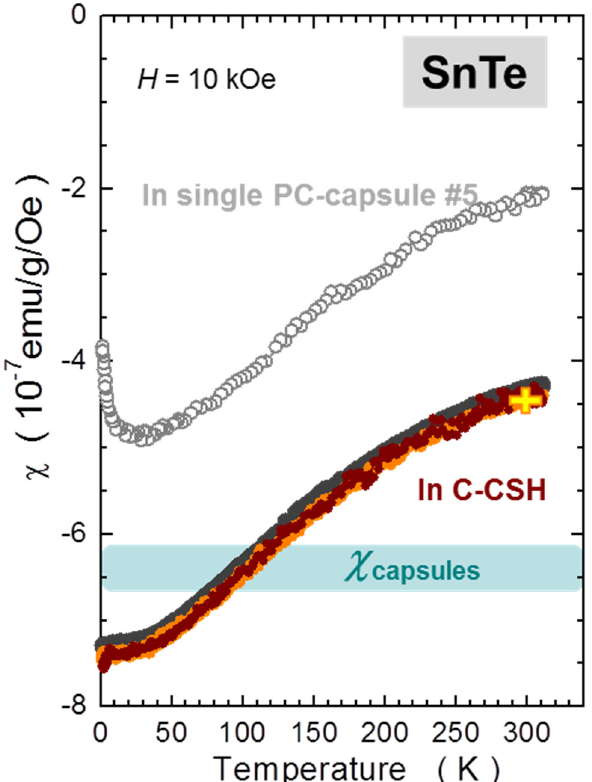
Figure 13. Temperature dependence of the magnetic susceptibility χ of SnTe established in this study by various methods. The background dark grey symbols mark the χ -benchmarking measurement of a large 58 mg crystal. Open gray symbols indicate the measurements of 2.1 mg crystallite in a single polycarbonate capsule #5. The orange symbols indicate the results obtained for the same minute crystallite mounted on a magnetically clean and uniform Si stick. The brown symbols indicate the results of the final method-validation test obtained when this small crystallite was mounted in the capsule compensated sample holder (C-CSH) elaborated in this study.